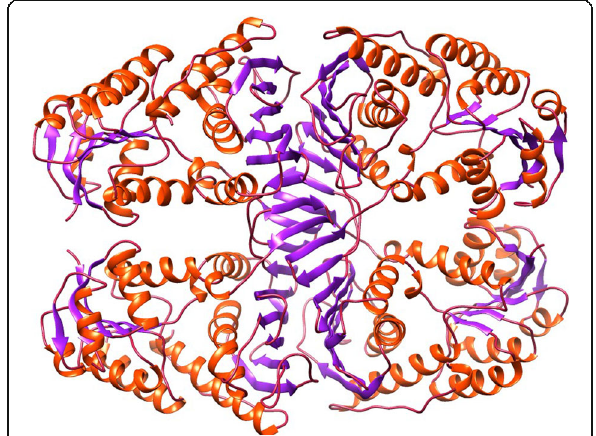
Fig. 1 Protein model of inositol 2-dehydrogenase (EJJ83173). The model was a homotetramer protein generated using the SWISS-MODEL